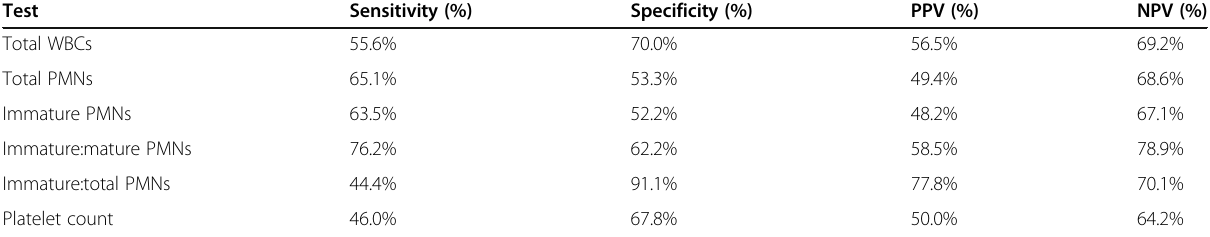
Table 6 Diagnostic performance of individual items of HSS for diagnosis of early-onset sepsis